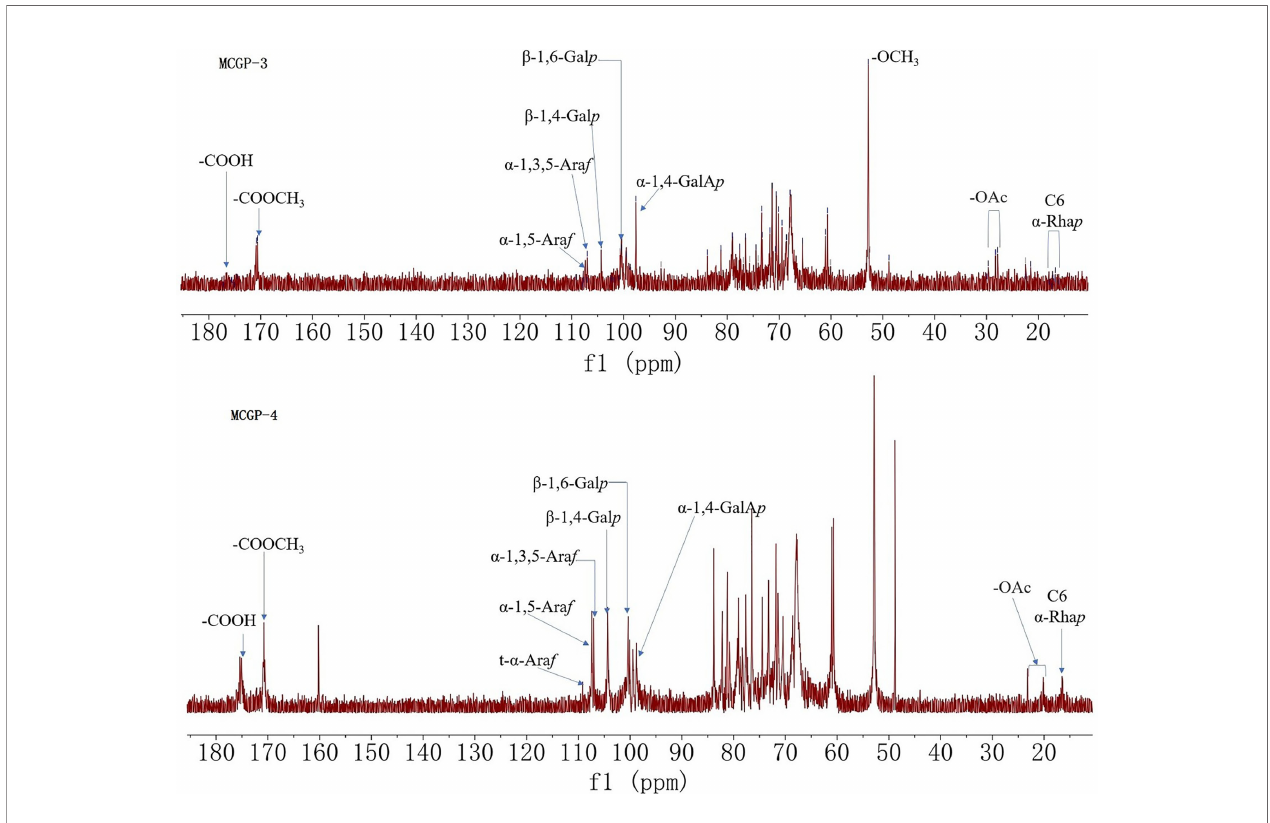
FIGURE 4 | 13 C NMR spectra of MCGP-3 and MCGP-4.